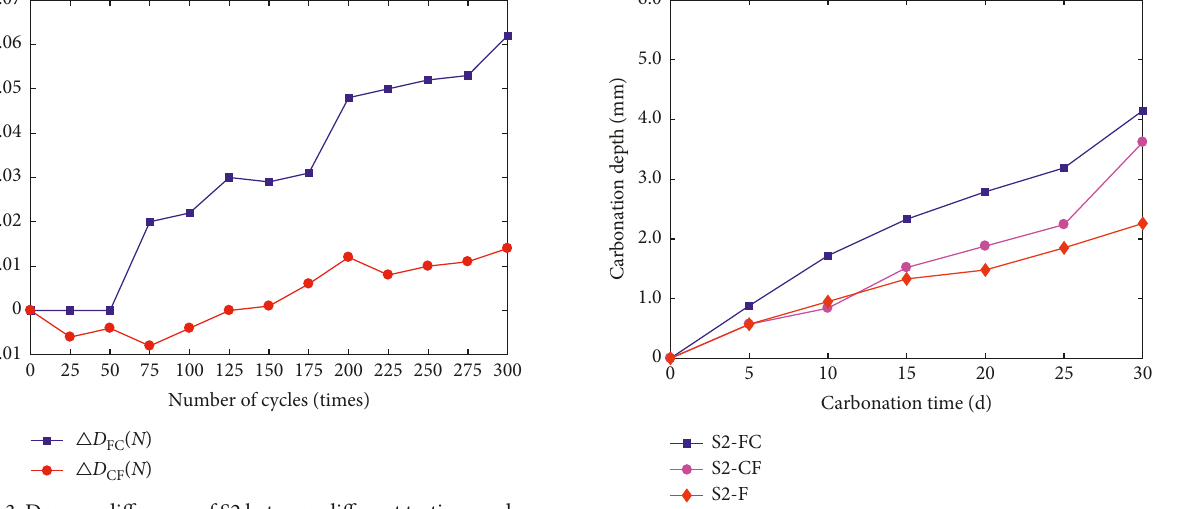
Figure 5: Carbonation depth of S2 in different testing modes.